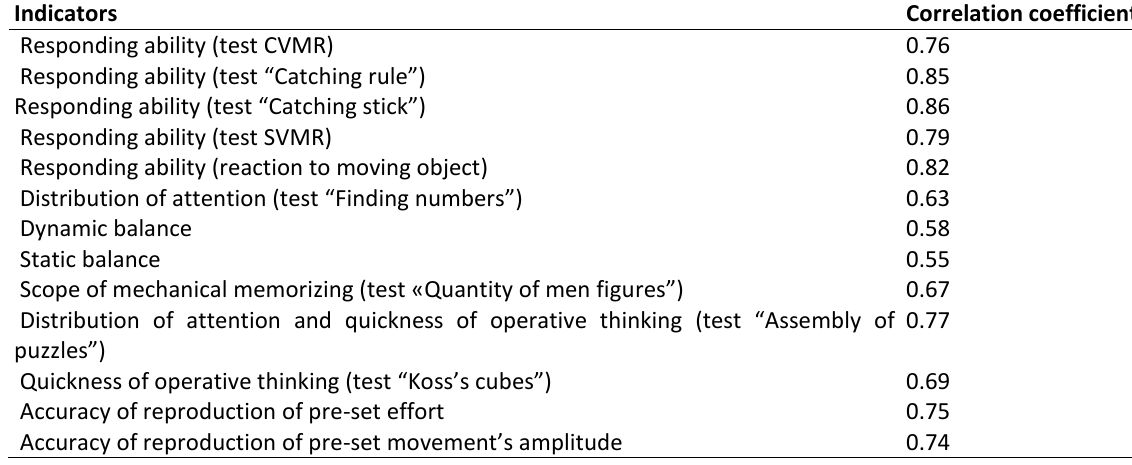
Table 2. Correlations of indicator, which characterizes quickness of attention re-switching, attention concentration and accuracy of fulfillment (test “Balls”), with indicators of orientation, responding